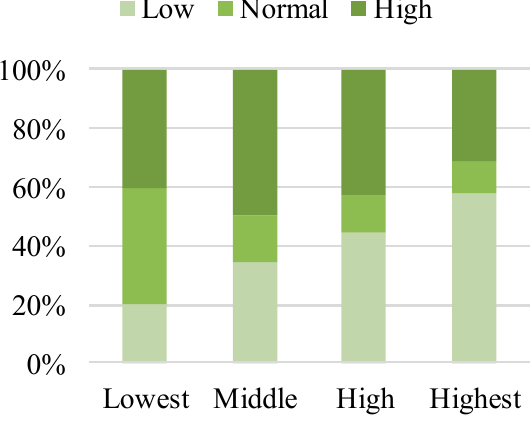
Figure 7. The price categorization during the year, as percentage, for the selected cases.